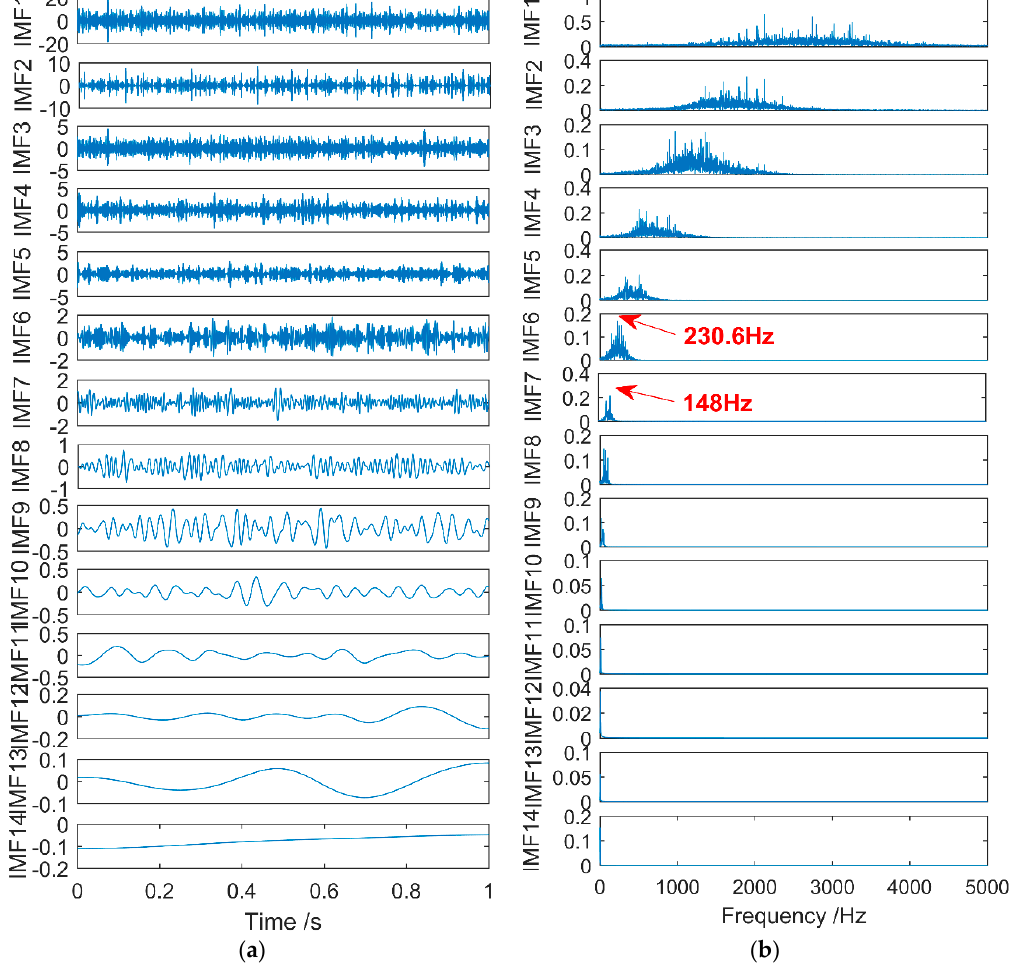
Figure 19. The time and frequency domain of reconstructed signal by CEEMD decomposition. ( a ) Time domain. ( b ) Frequency domain.